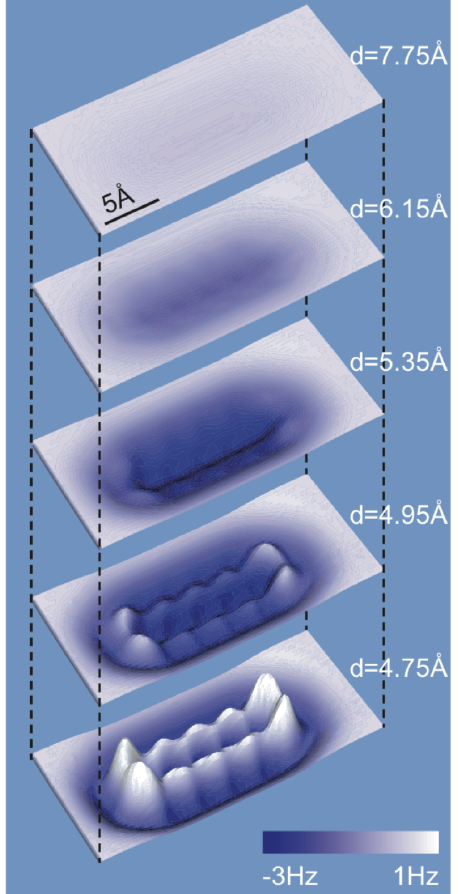
Figure 13. 3D contours of computed frequency shift for five different intermolecular distances d . The contour area is 23.6Å × 10.6Å. Adapted with permission from Institute of Physics from Figure 5 in